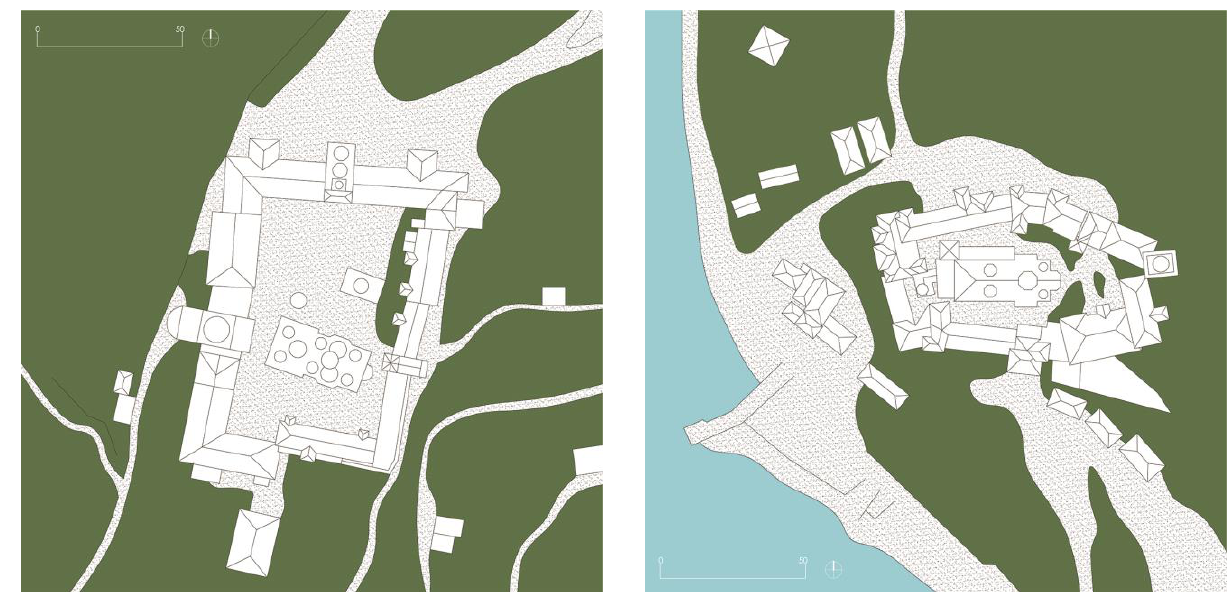
Figure 13 . The Monastery of Zografo. General plan.